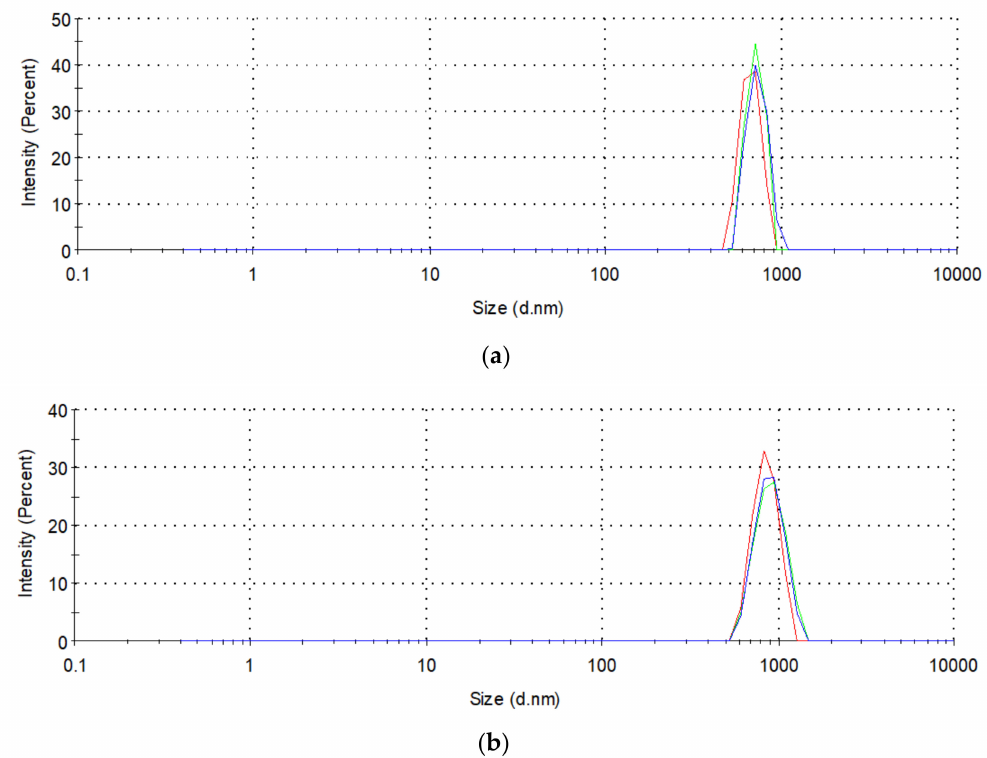
Figure 1. Dynamic light scattering method (DLS) size distribution of liquid formulation with CBD liposome ( a ) and liquid formulation without CBD, liposomes only ( b